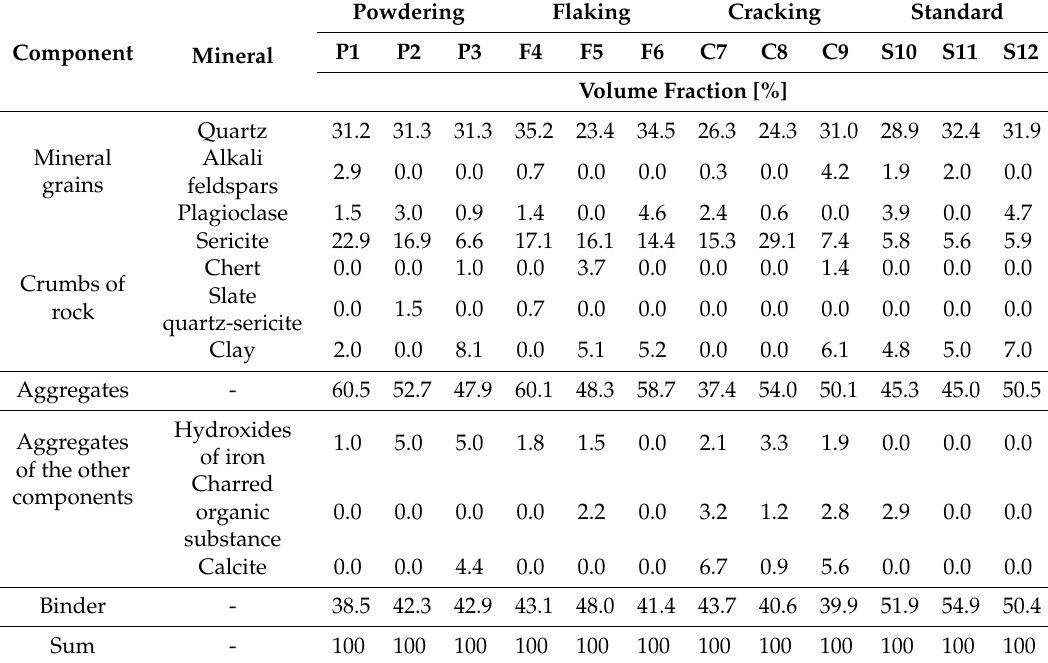
Figure 6. Macroscopic view of a brick without signs of damage ( a ). Optical microscope image of a brick with compressive strength of 40 MPa. Abundant binder between the grain components ( b ). Microstructure of bricks without signs of damage, visible phases with clear vitrification ( c ). Table 1. Fractions of mineral components in bricks with various forms of